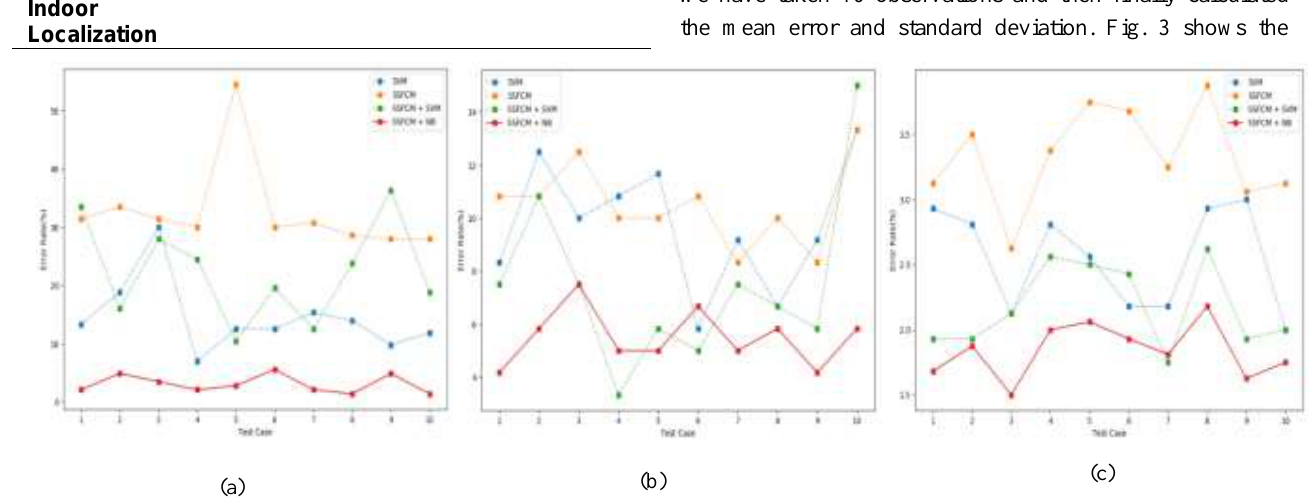
Figure 3. Error Rate of Misclassification in Real data (a) Iris (b) Wine (c) Wireless Indoor